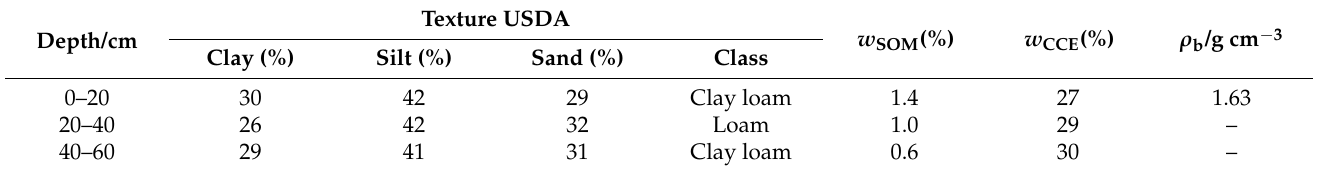
Table 1. Summary of the main soil characteristics 1 in the citrus orchard at the beginning of the study.